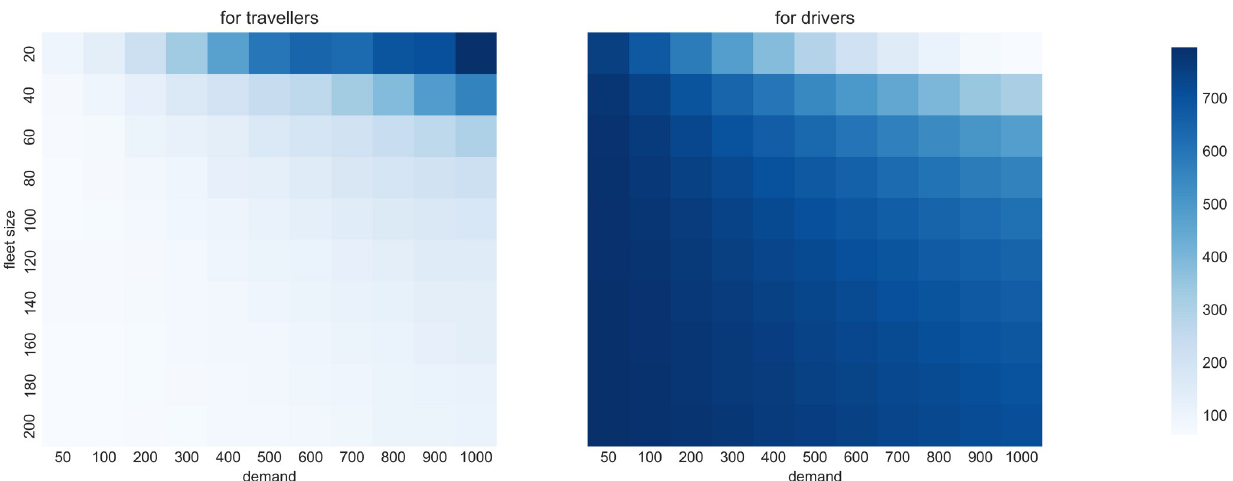
Fig 5. Service performance for various demand and supply levels. Average waiting times for travellers (left) and drivers (right), which follow mirroring diagonal trends.